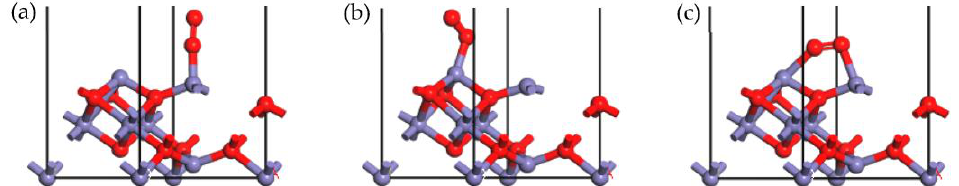
Figure 7. Stable adsorption configurations of O 2 onto Fe tet site ( a ), Fe oct site ( b ), and Fe tet site + Fe oct site ( c ) of the γ -Fe 2 O 3 (111) surface (N, blue; Fe, purple; O, red).